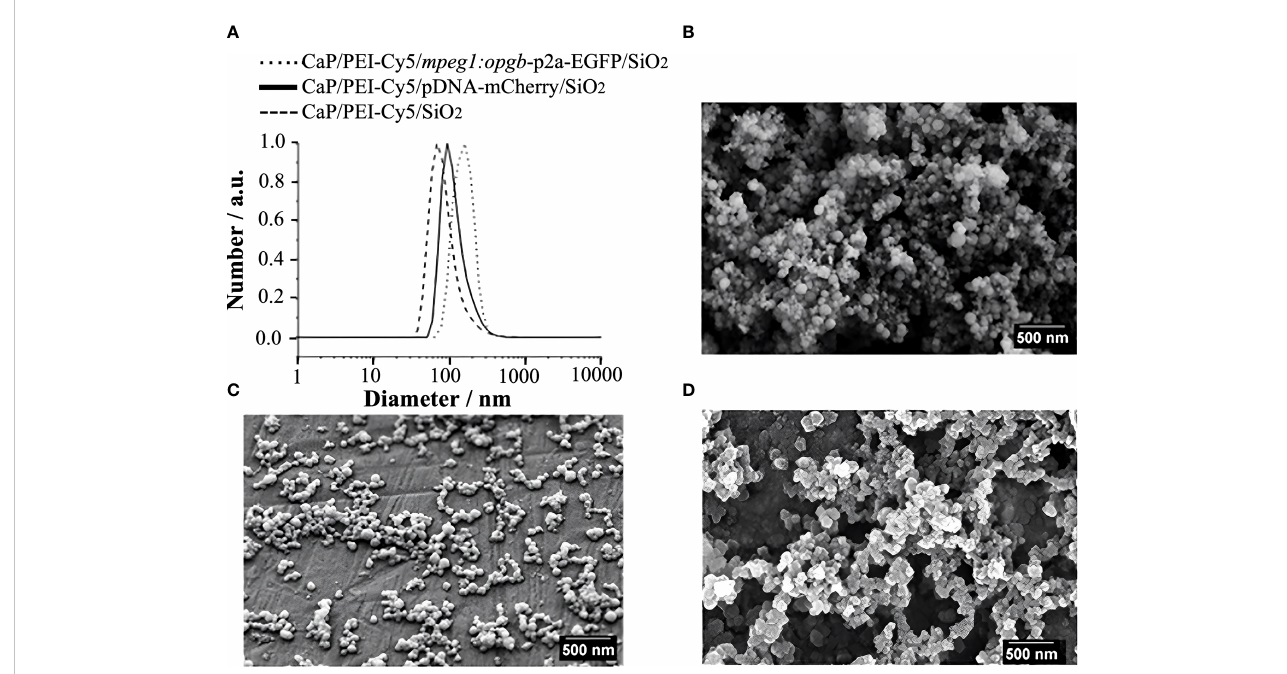
FIGURE 1 Characterization of CaP nanoparticles. (A) Dynamic light scattering (particle size distribution by number) of water-dispersed nanoparticles. (B) SEM image of CaP/PEI-Cy5/SiO 2 nanoparticles. (C) SEM image of CaP/PEI-Cy5/pDNA-mCherry/SiO 2 nanoparticles. (D) SEM image of CaP/PEI-Cy5/ mpeg1:opgb-